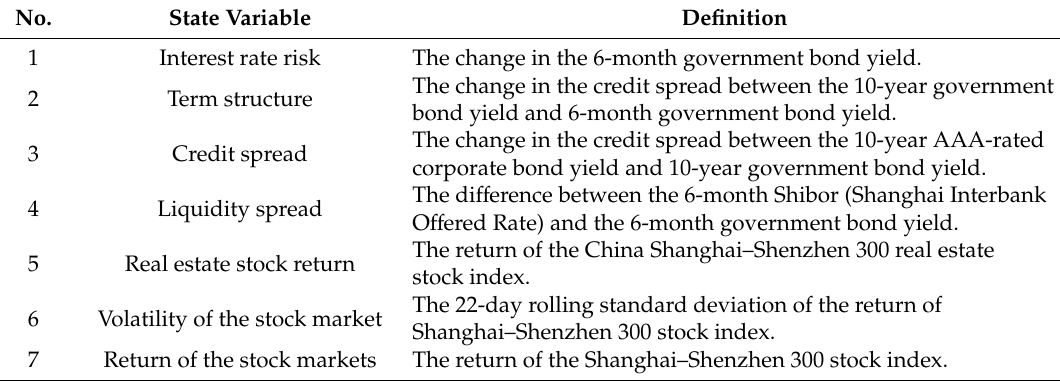
Table 3. The system of the state variables that used in the dynamic CoVaR 1